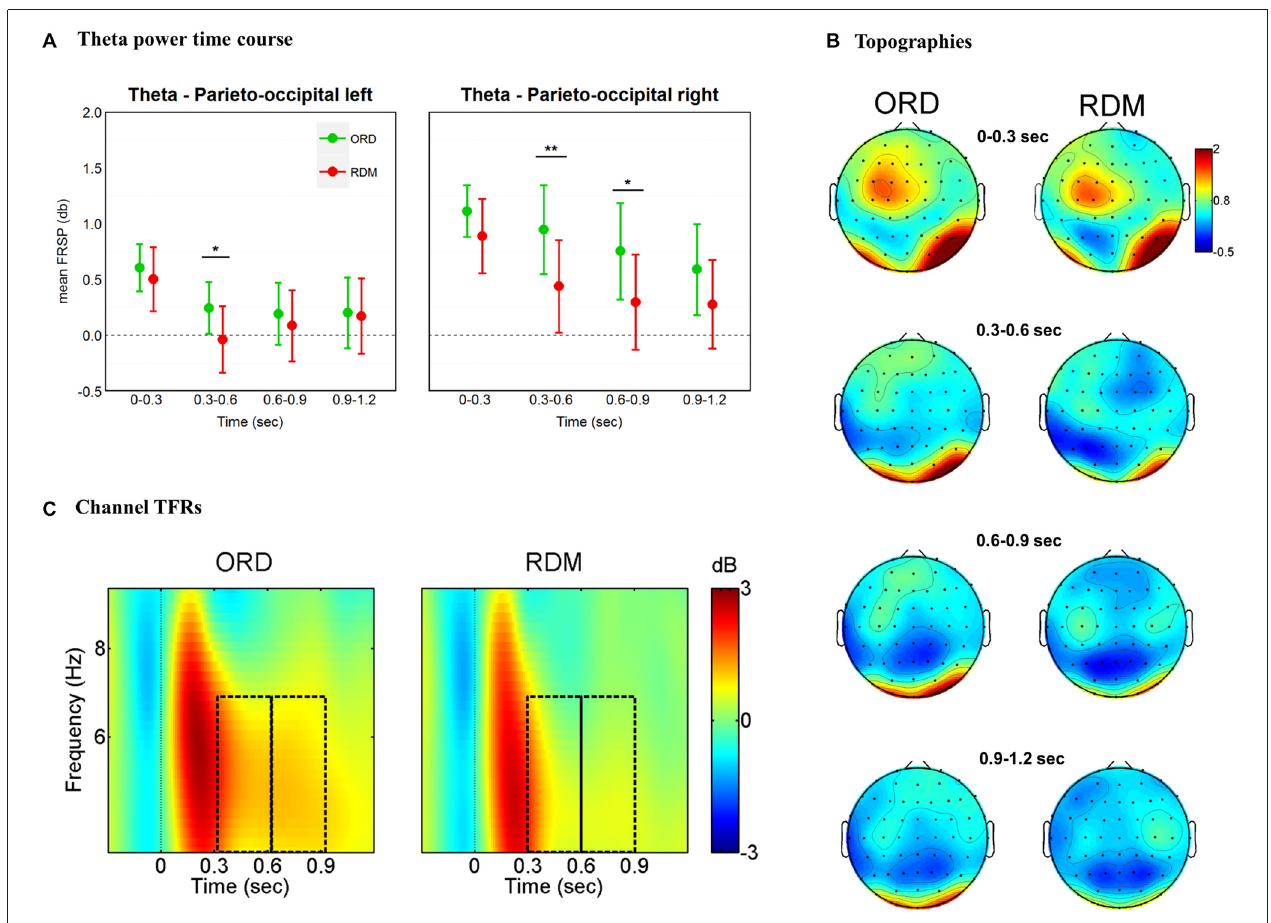
FIGURE 3 | Theta band (4–7 Hz) effects time-locked to sentence onsets. (A) Time course of theta power for left and right parieto-occipital clusters. Mean power values are plotted in successive 300 ms time windows, up to 1200 ms. Error bars represent 95% confidence intervals. Significant differences between conditions are marked with asterisks: ** p < 0.01; * p < 0.05. (B) Topographic maps of theta (4–7 Hz) power change in successive 300 ms time windows, up to 1200 ms. (C) TF representations of power changes at the sentence-level analysis. The black rectangles indicate the time windows (300–600 ms and 600–900ms) where theta power was larger for syntactically correct sentences compared to the condition where the order of the words was pseudo-randomized. Results are plotted for one representative channel (PO4).